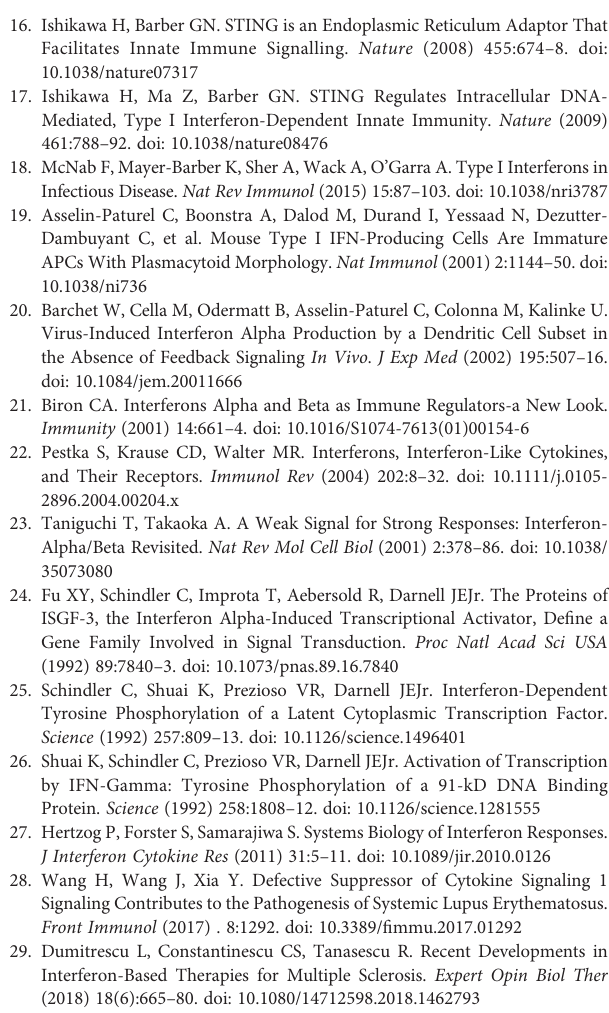
Figure 4 . JJ contributed to the fi rst part (introduction)